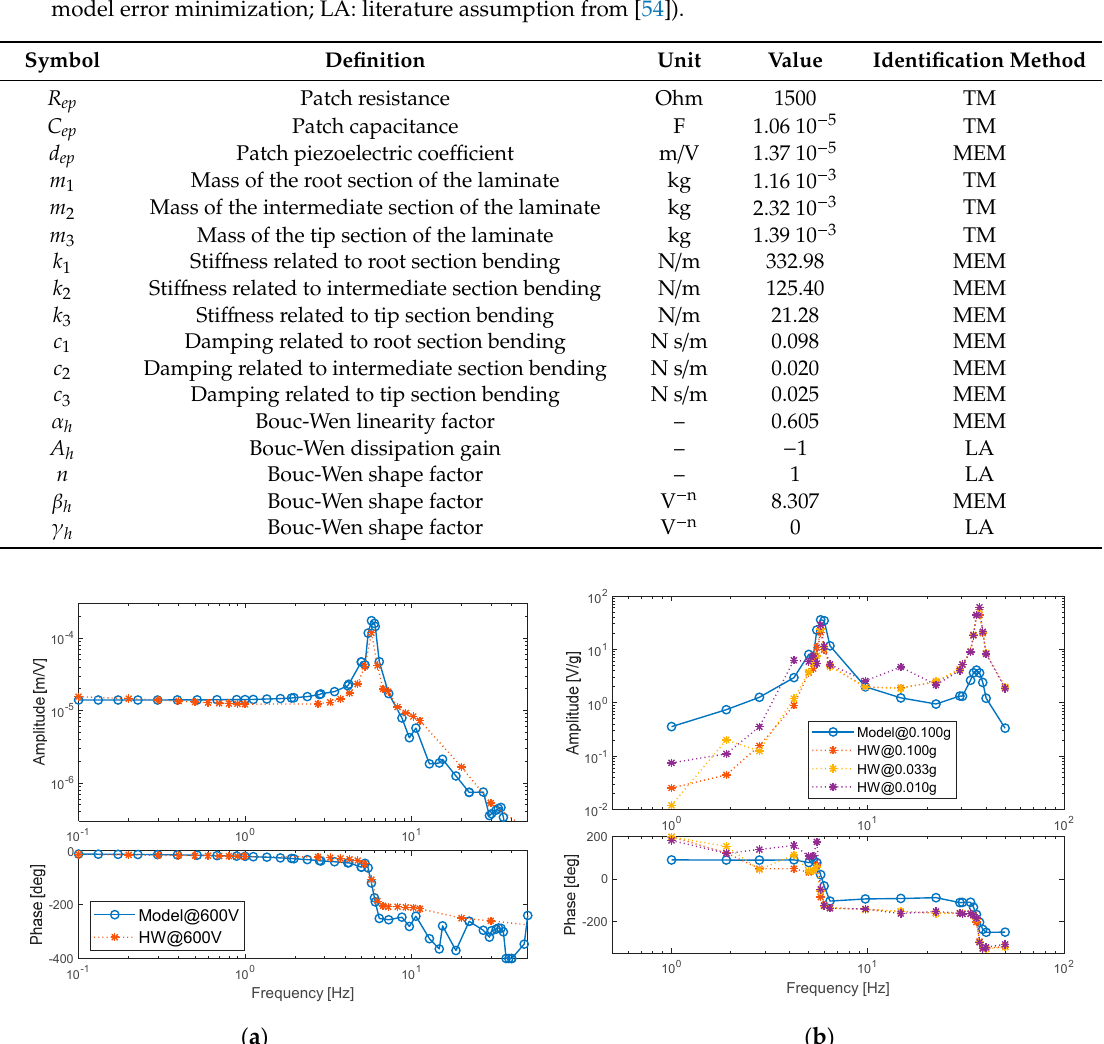
Figure 6. Model parameters’ tuning via frequency-domain responses: ( a ) deformation response to voltage input; ( b ) stored voltage response to base acceleration input.